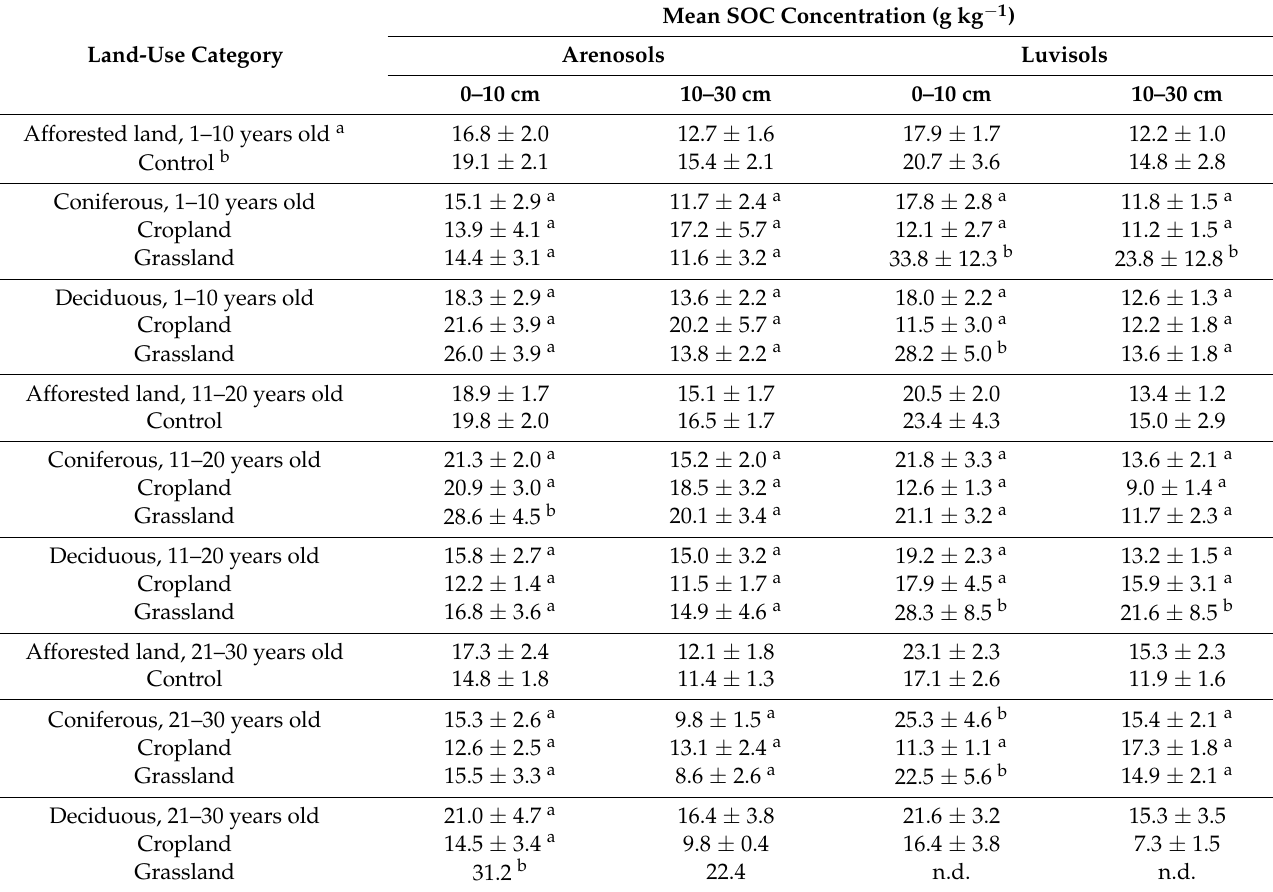
Table 4. Mean concentrations (g kg − 1 ) of soil organic carbon (SOC) in mineral topsoil of Arenosols and Luvisols [47]. Different letters a and b indicate significant differences between the means of different land uses within one topsoil layer of each Arenosol and Luvisol at p <